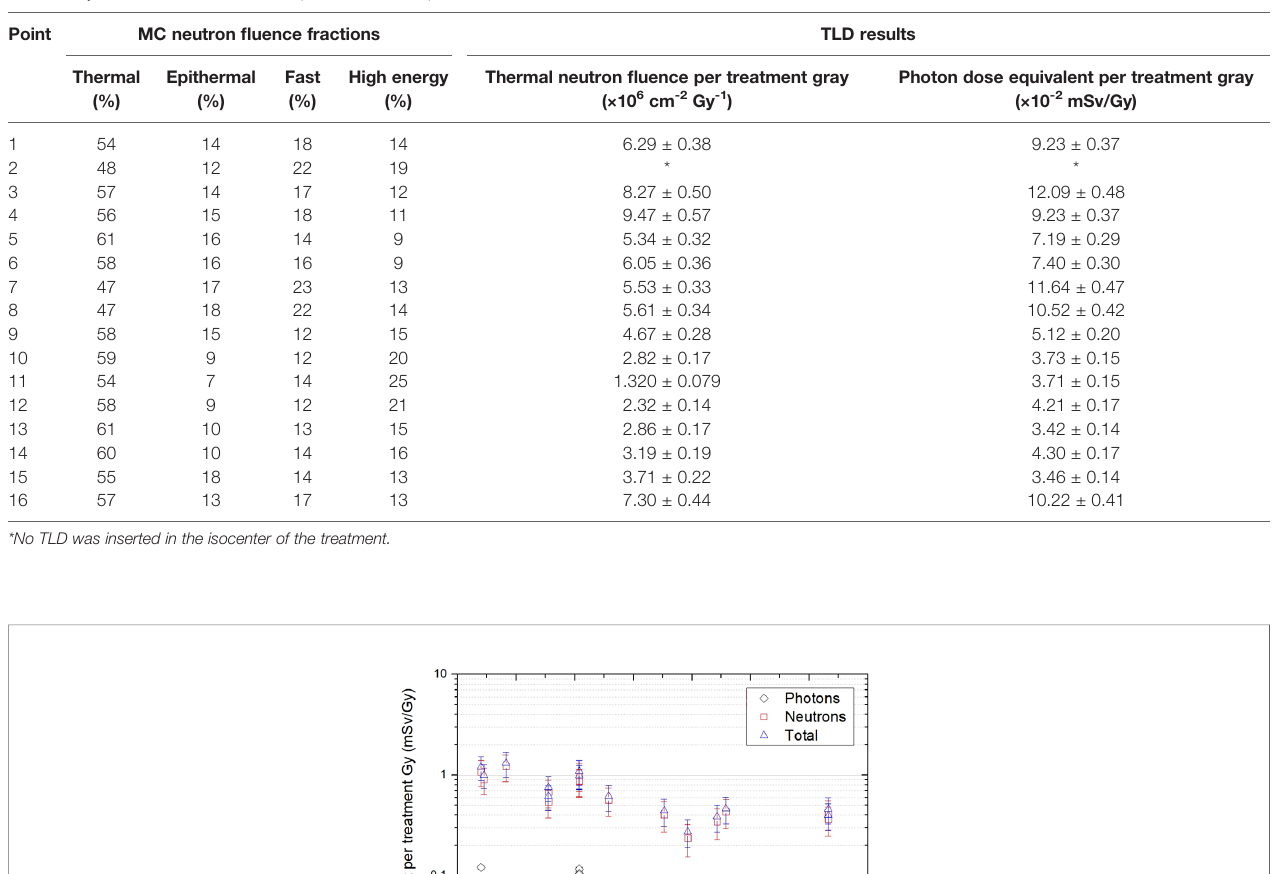
TABLE 4 | Quantities evaluated in the points inside the phantom.